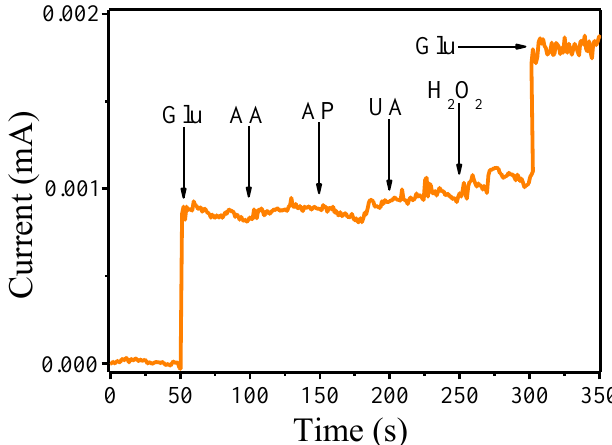
Figure 6. Amperometric response of Ir-Au-Pt microelectrode to successive addition of 50 µ M D-glucose (Glu), 10 µ M ascorbic acid (AA), 10 µ M 4-acetamidophenol (AP), 10 µ M uric acid (UA), 10 µ M hydrogen peroxide (H 2 O 2 ) in 0.1 M NaOH.